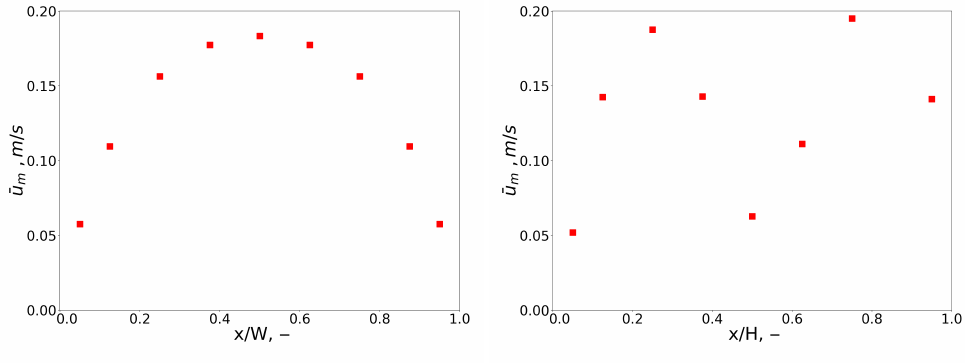
Figure 12. Change of the scalar metric of the streaming flow along the width ( left ) and height ( right ) of the